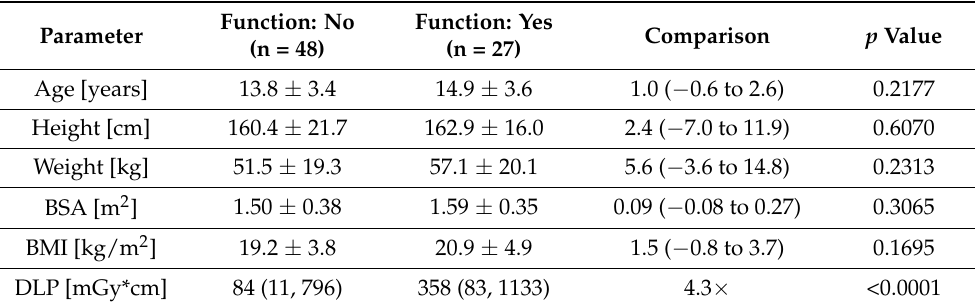
Table 5. Influence of cardiac function assessment on radiation dose of cardiac CT scan in children. Selection limited to patients aged > 8.1 y.o. for exclusion of bias.